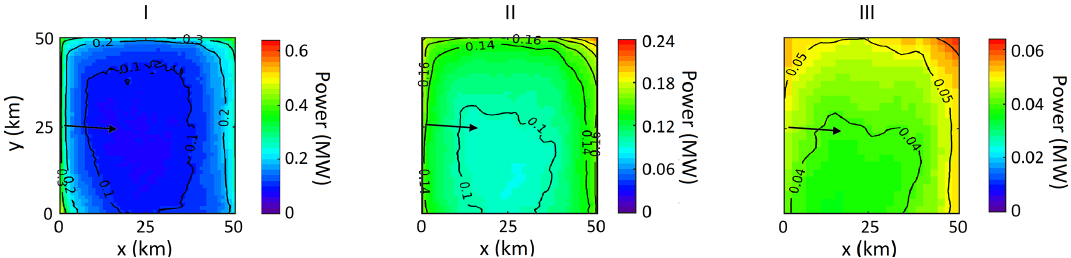
Figure 3. Averaged power (MW) generated in the WF cases: I, II and III. Power is averaged over 5 sea-breeze days for 12:30 to 17:30IST. The black arrow represents the prominent wind direction. It is to be noted here that colorbars for cases I, II and III have different upper limits.